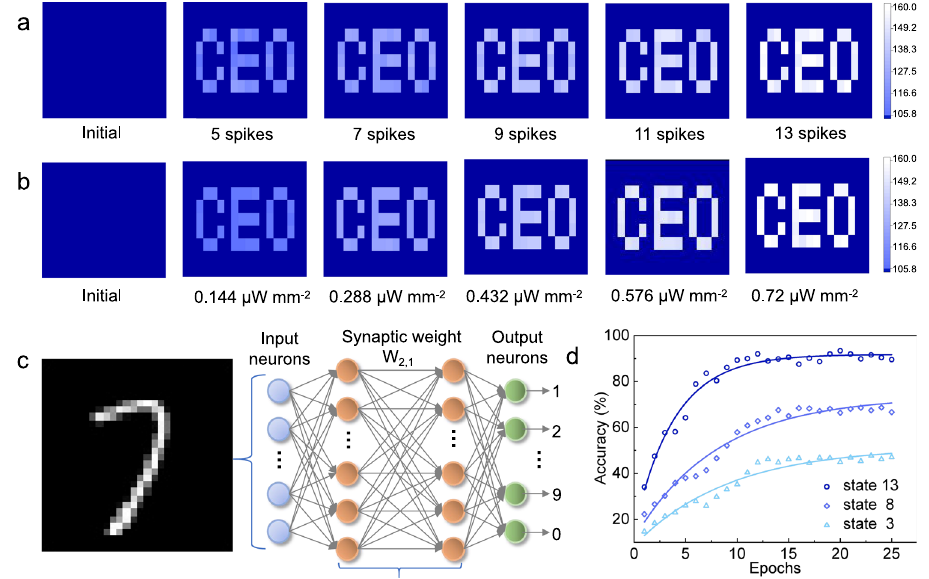
Fig. 5 | Image memorization and recognition. Measured weights of a “ CEO ” pattern image in the initial state and a after training with 5, 7, 9, 11, and 13 spikes under 365nm light with a power density of 0.288 μ Wmm − 2 (pulse width, 500ms; pulse interval, 500ms), b after training with various power densities of